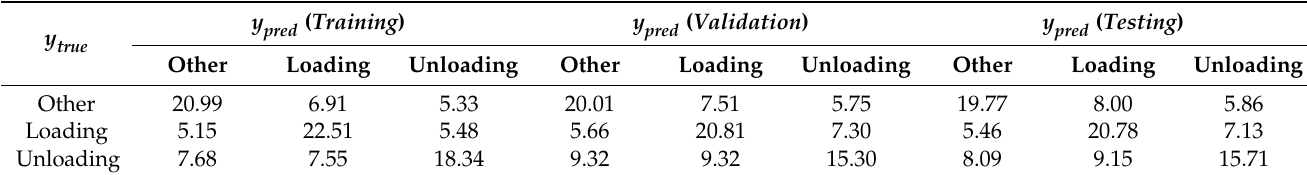
Table 5. Confusion matrix created for loaders network model.